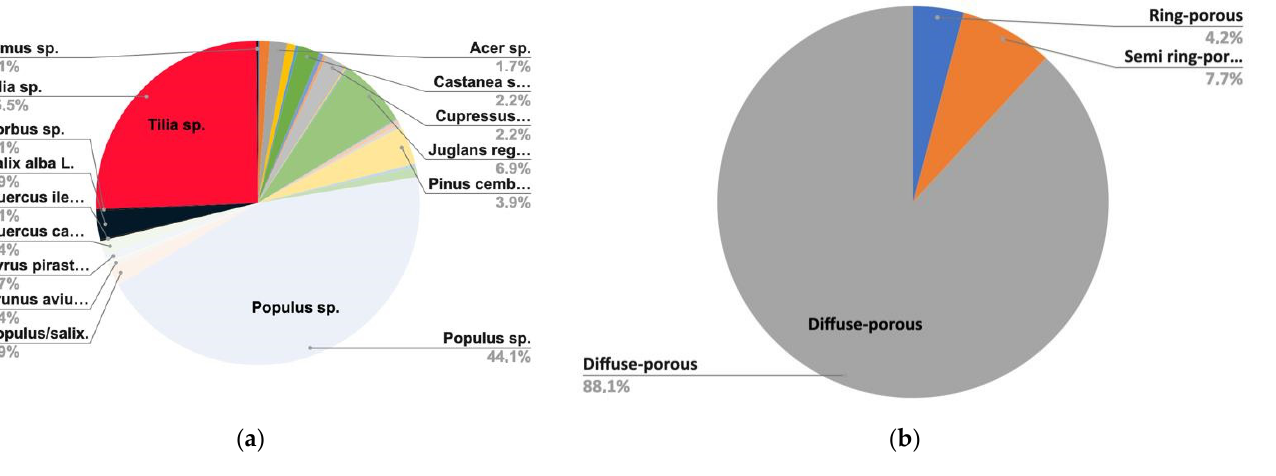
Figure 3. On the left ( a ) is the distribution of the identified timbers, while on the right ( b ) is the hardwood anatomical typologies.